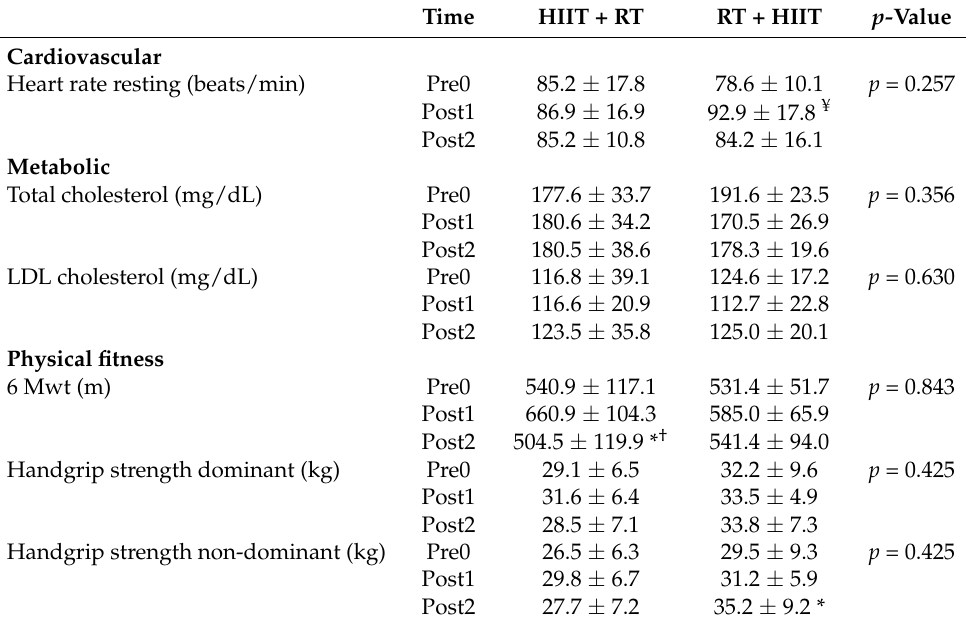
Table 2. Comparison between groups according to anthropometric cardiovascular, metabolic, and fitness